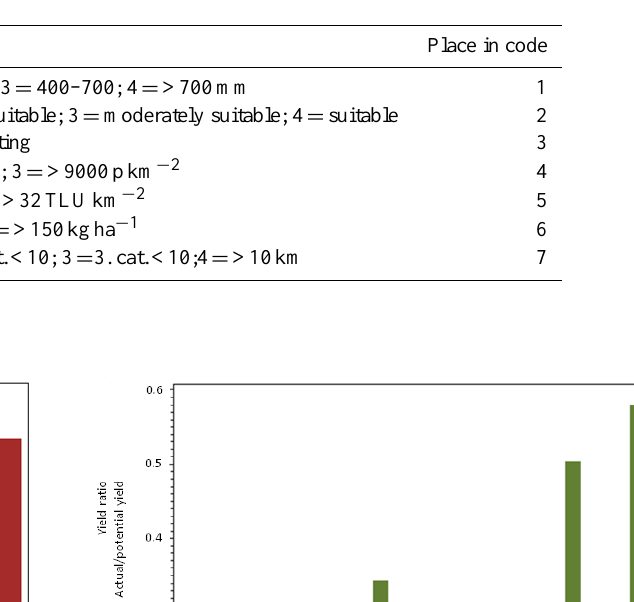
Table 4. Variables and encoding of categories used to make uniform sites.